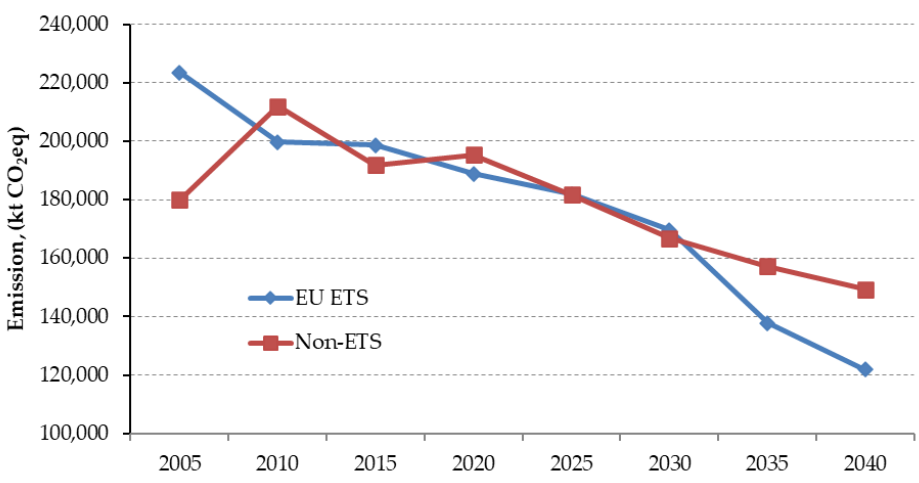
Figure 9. Expected emission in EU ETS and non- ETS sector in Poland [42].